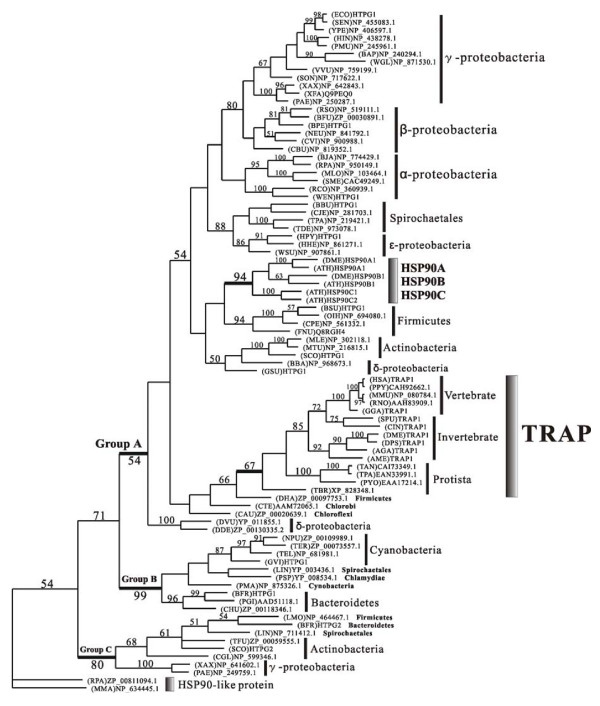
Most parsimonious tree inferred from HTPG and TRAP proteins with representative HSP90A, HSP90B and HSP90C members, rooted with HSP90-like proteins existing in Archaea and Bacteria. Bootstrap percentages of 5000 replicates are shown above the branches where they exceed 50%. Branch lengths are proportional to the number of character changes.